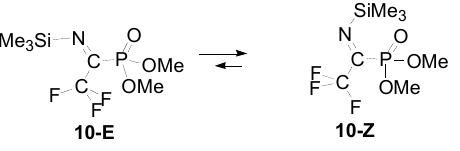
Scheme 4. Isomerization of 10 .